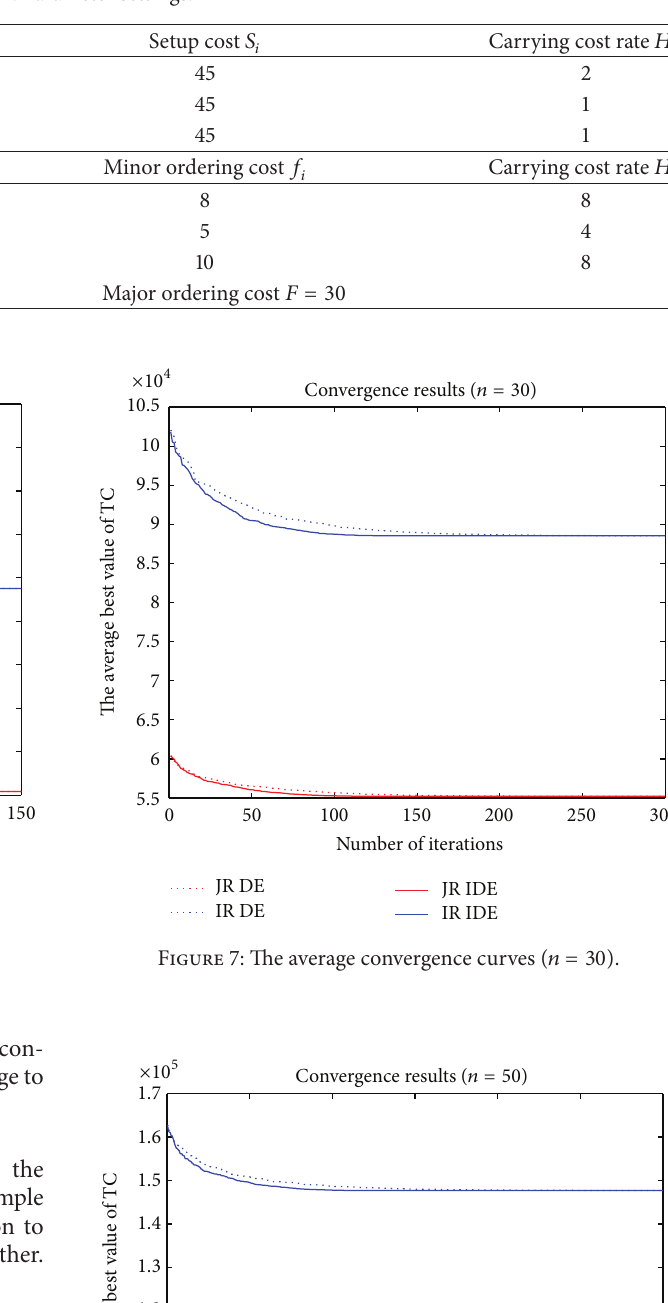
Table 4: Parameter settings.